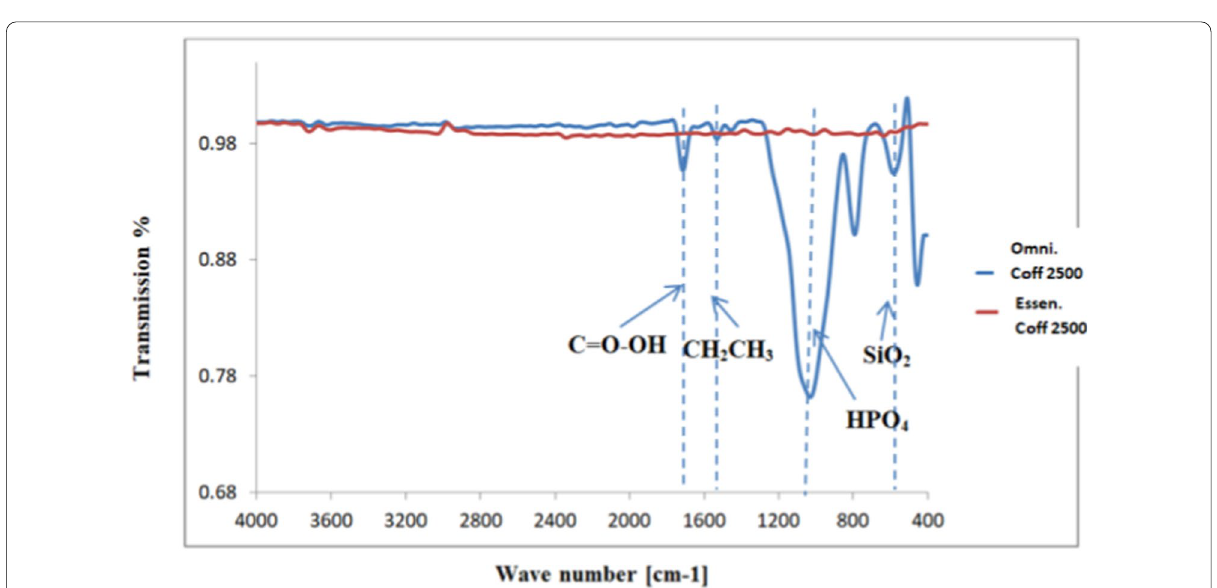
Fig. 8 FTIR spectra representing the chemical structure of Omnichroma Coff 2500 and Essentia Coff